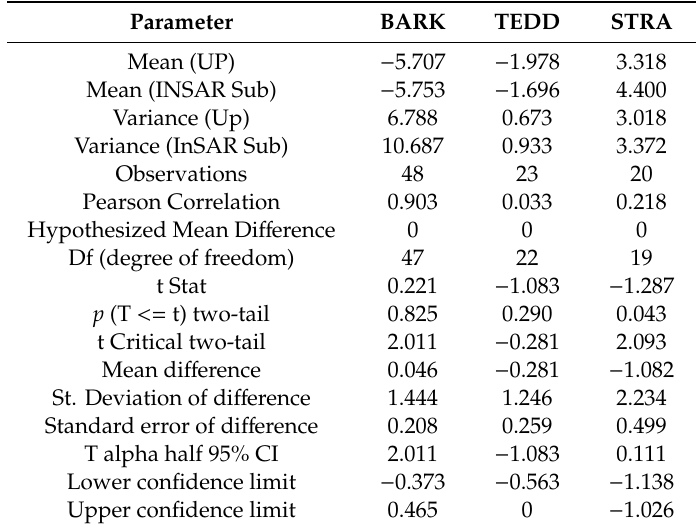
Figure 7. Time series comparison for InSAR subsidence and GNSS up values at ( a ) Bark ( b ) Tedd and ( c ) Stra stations. Table 5. Two-paired t -test for GNSS and InSAR land